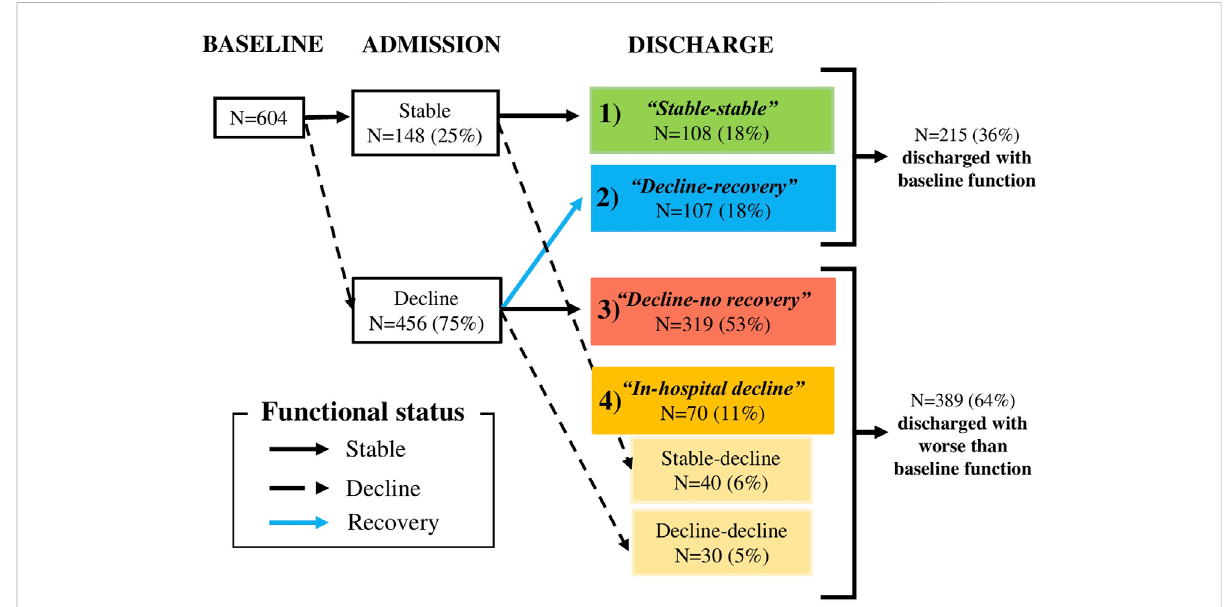
FIGURE 2 Functionalstatuschangesacrossthethreetimepointsofbaseline(2 weeksbeforeadmission),hospitaladmission,anddischarge. “ Stable ” refers to the ADLs score remaining constant between two time periods; “ decline ” refers to the loss of ADLs between two time periods; “ recovery ” refers to the subjects who recover baseline function at hospital discharge. Boxes at discharge depict the four mutually exclusive functional trajectories of ADLs:1) “ stable-stable ” denotesprehospital andin-hospital stability, 2) “ decline-recovery ” denotesprehospitaldeclineandin-hospital recovery at discharge, 3) “ decline-no recovery ” denotes prehospital decline and no recovery at discharge, and 4) “ in-hospital decline ” denotes in-hospital decline, with or without prehospital decline. The right side of the fi gure depicts overall results of the functional